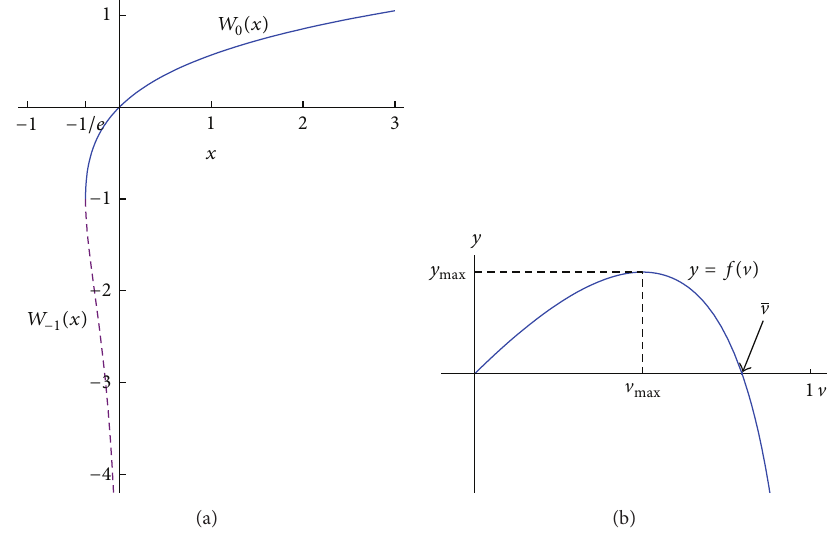
Figure 6: (a) The two real branches of the Lambert 𝑊 function. (b) Graph of the function 𝑓